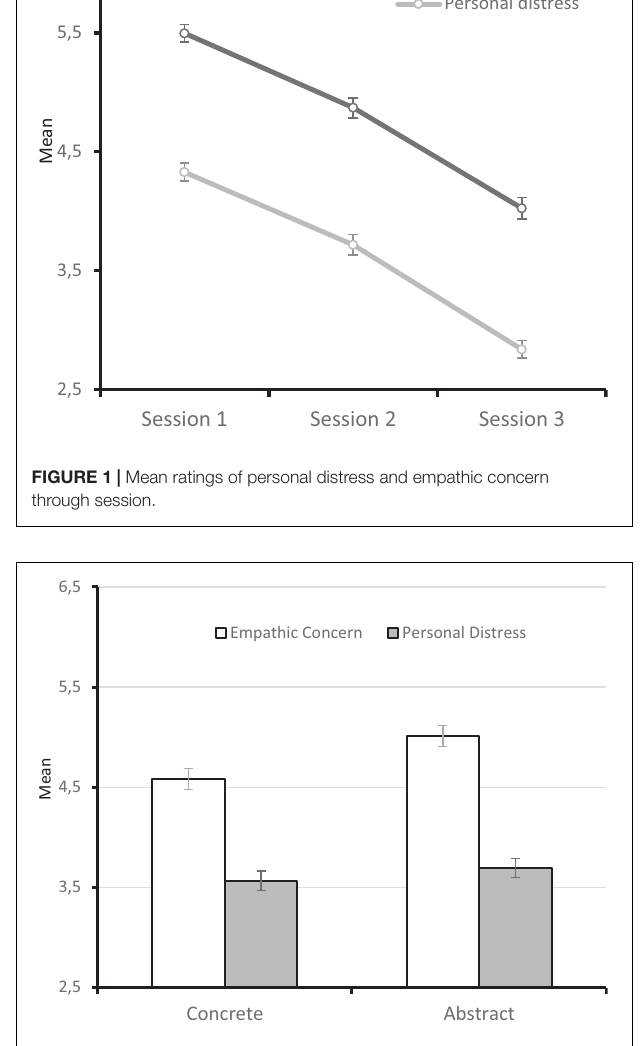
FIGURE 2 | Mean ratings of empathic concern and personal distress for concrete and abstract